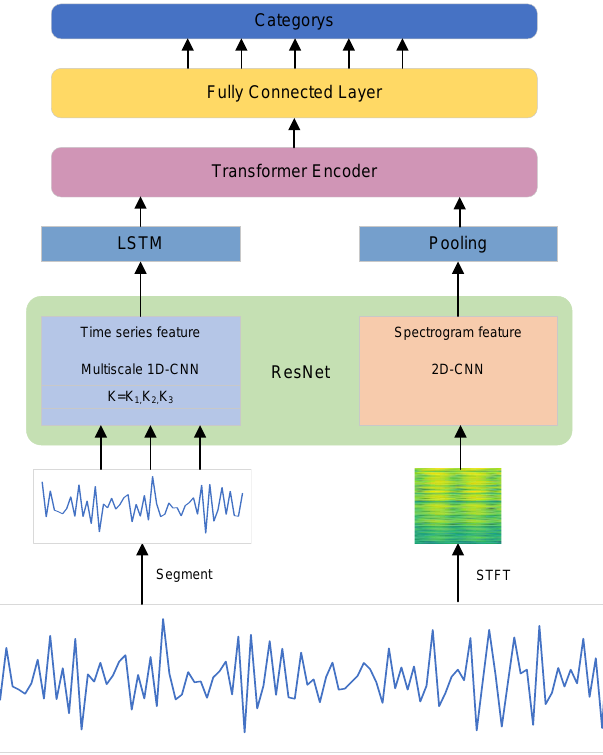
Figure 3. Network architecture of the proposed